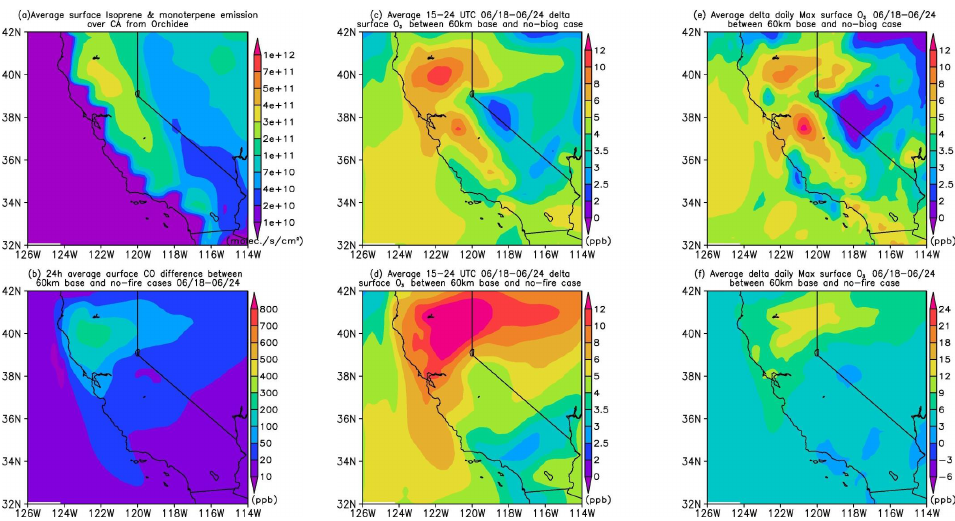
Fig. 6. (a) Average surface isoprene and monoterpene emissions from the Orchidee EI. (b) 24h-average differences of surface CO between Figure 6 (a) Average surface isoprene and monoterpene emissions from the Orchidee EI (b) 24h-average differences of surface CO between base and no-fire cases in 60 km grids; Surface O 3 differences between (c;e) base and no-biogenic cases and (d;f) base and no-fire cases of base and no-fire cases in 60km grids; Surface O 3 differences between (c, e) base and no-biogenic cases and (d, f) base and no-fire cases of (c–d) averaged 15:00–24:00UTC (08:00–17:00UTC) and (e–f) average daily maximum O 3 in 60km grids. Table 3. Correlation ( R ), Mean Biases (MB), Root Mean Square Error (RMSE) between modeled and observed SO x along all SC flight tracks (all altitudes). Higher correlations, lower MB and RMSEs are in bold. Note that model comparisons refer to SC locations where measurements are available for individual teams, and the compared locations differ between teams.